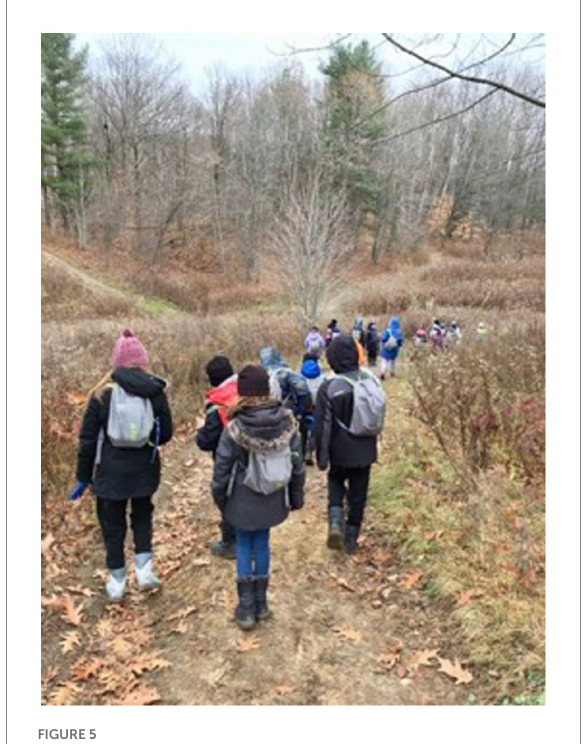
FIGURE 5 Outdoor learning on foot in a wooded